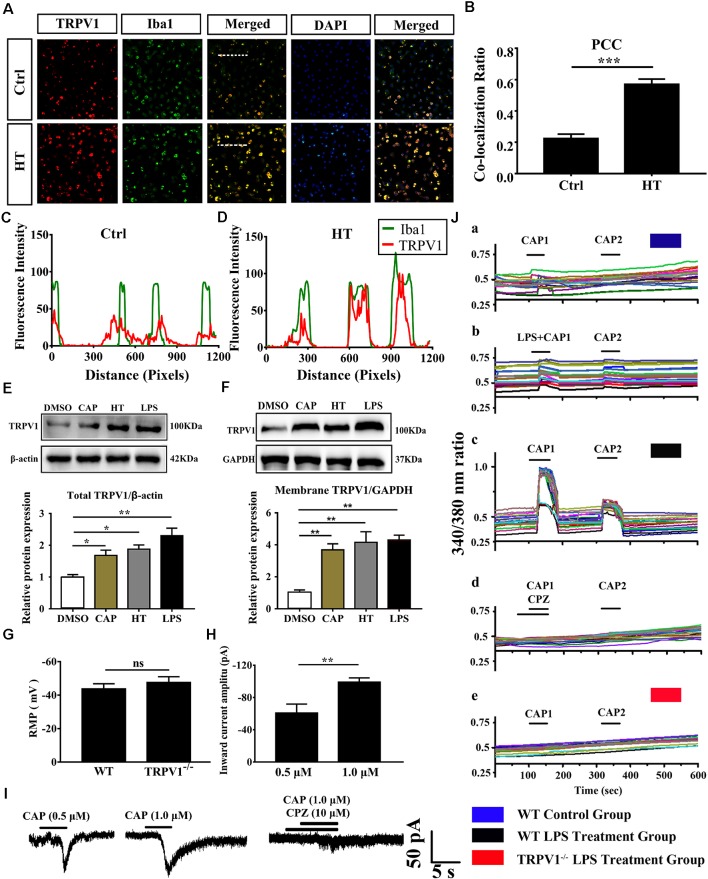
The expressed and electrophysiology properties of TRPV1 in primary cultured microglia. (A) Photomicrograph immunocytochemistry indicated different co-expression of TRPV1 (visualized in red Cy3), Iba1 (visualized in green FITC), and cell nuclei (visualized in dark blue DAPI) from control and hyperthermia groups microglia. Note the colocalization indicated by merge yellow fluorescence, the fluorescence intensity of TRPV1 and Iba1 along the indicated line were scanned by using ImageJ software, and their colocalization was determined by the PCC method (C,D; Scale bars: 50 μm). (B) The histograms represent the ratio of the mean PCC calculated from the colocalizating in three samples (n = 3 per groups, ***p < 0.001, unpaired, two-tailed Student’s t-test compared with control). (E,F) Representative Immunoblot bands and densitometric analysis of total protein (E) and membrane protein expression (F) of TRPV1 in cortical primary cultured microglia with or without pretreatment of CAP (10 μM), hyperthermia (43°C, 4*30 min) or LPS (1.0 μg/ml, 24 h). Data were presented as means ± SEM, n = 3 per groups, *p < 0.05, **p < 0.01, one-way analysis of variance (ANOVA) followed by Dunnett’s multiple comparison test with DMSO. Ctrl, Control; CAP, capsaicin; HT, hyperthermia. (G) Whole-cell patch clamp (I = 0 mode) recorded resting membrane potential (RMP) in microglia from wild-type (WT) and TRPV1−/− mice (n = 11 per groups, ns, not significant, unpaired, two-tailed Student’s t-test compared with WT). (H) TRPV1 currents amplitude (pA) is significantly increased in 1.0 μM capsaicin group (−99.05 ± 2.632, n = 4) than 0.5 μM capsaicin group (−60.73 ± 6.445, n = 3) in cortical activated microglia (**p < 0.01, unpaired, two-tailed Student’s t-test compared with 0.5 μM CAP). (I) Representative whole-cell voltage-clamp mode recorded current traces from individual primary microglia challenged by 0.5 μM, 1.0 μM Capsaicin and Capsazepine (10 μM) applications, the largest current is 104.9 pA in 1.0 μM capsaicin perfusion pretreatment with LPS (1.0 μg/ml, 24 h). (J) Representative traces of intracellular calcium ([Ca2+]i) responses by CAP (1.0 μM), (Ja,b) CAP (1.0 μM) with LPS (1.0 μg/ml) in microglia from WT mice. (Jc,d) Representative traces of CAP (1.0 μM) induced-([Ca2+]i) response in LPS (1 ng/ml, 24 h)-stimulated microglia and to Capsazepine (10 μM). (Je) Representative traces of CAP (1.0 μM) induced-([Ca2+]i) response in LPS (1.0 μg/ml, 24 h)-stimulated microglia in TRPV1−/− mice microglia.